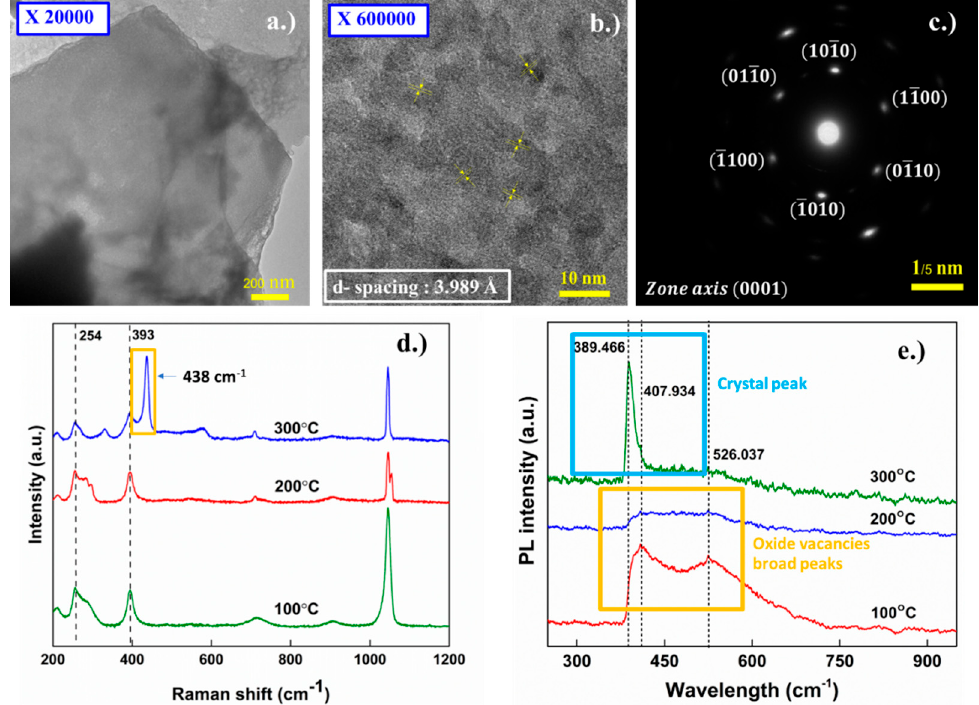
Figure 5. Transmission electron microscopy (TEM) image at ( a ) lower; and ( b ) higher resolution of ZnO flakes grown for 30 min prior to annealing at 300 °C for 1 h in ambient environment; ( c ) Electron diffraction and zone analysis for the crystals; and ( d ) Raman spectrum and; ( e ) photoluminescence (PL) results of flakes grown for 30 min then annealed at different temperatures.